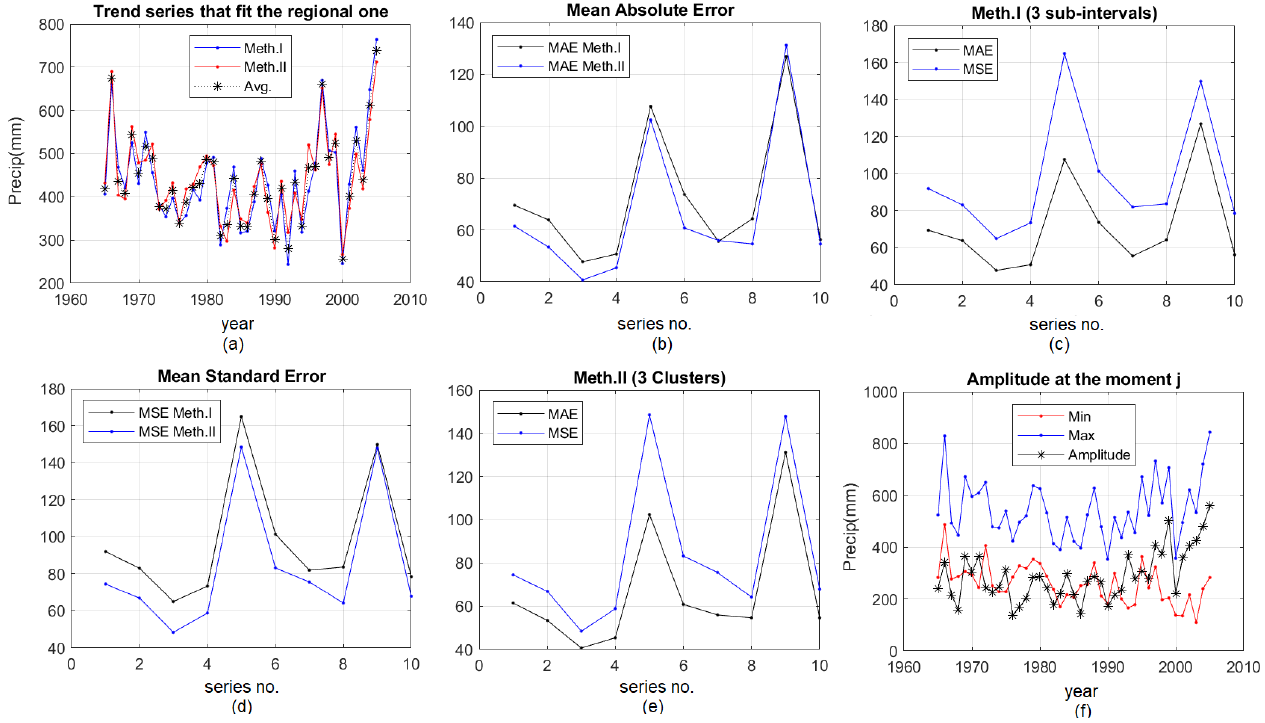
Figure 10. Study results when using three intervals/clusters ( a ) “Trend series that fit the regional one”; ( b ) MAE in both methods; ( c ) MAE and MSE in Method I; ( d ) MSEs from both methods; ( e ) MAE and MSE from Method II; ( f ) Minimum, Maximum and Amplitude Series amplitude. Table 2. The goodness of fit indicators in Methods I with two and three intervals for annual pre- cipitation.